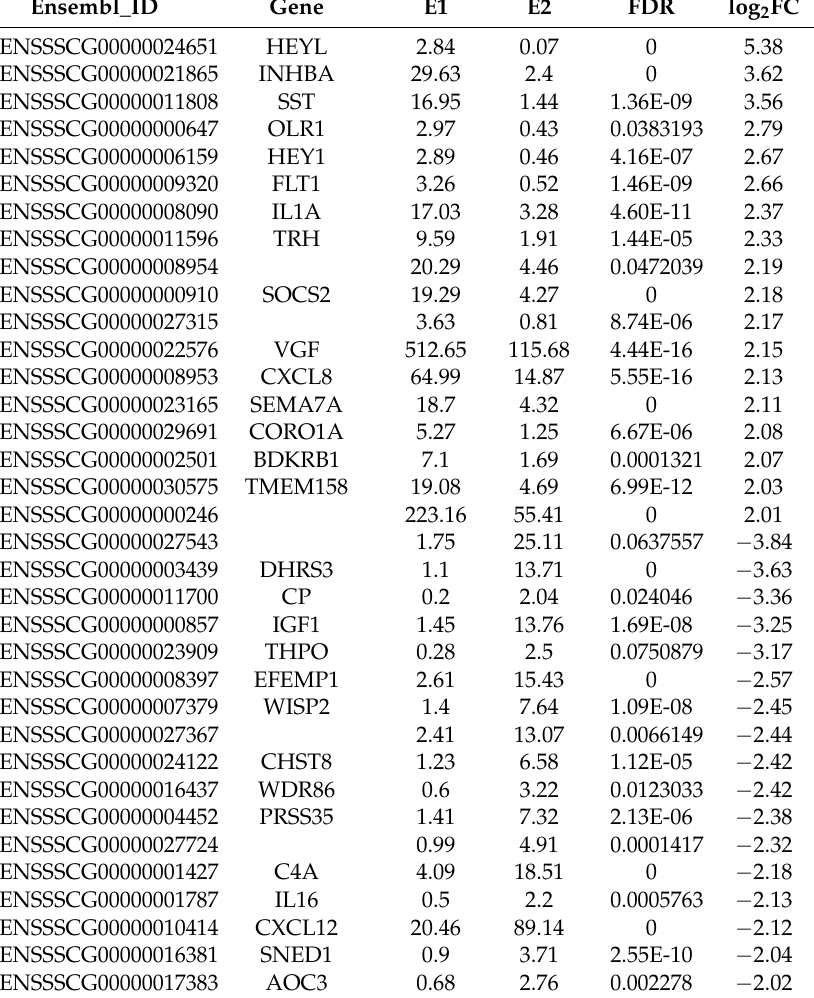
Table 3. Differential gene screening in